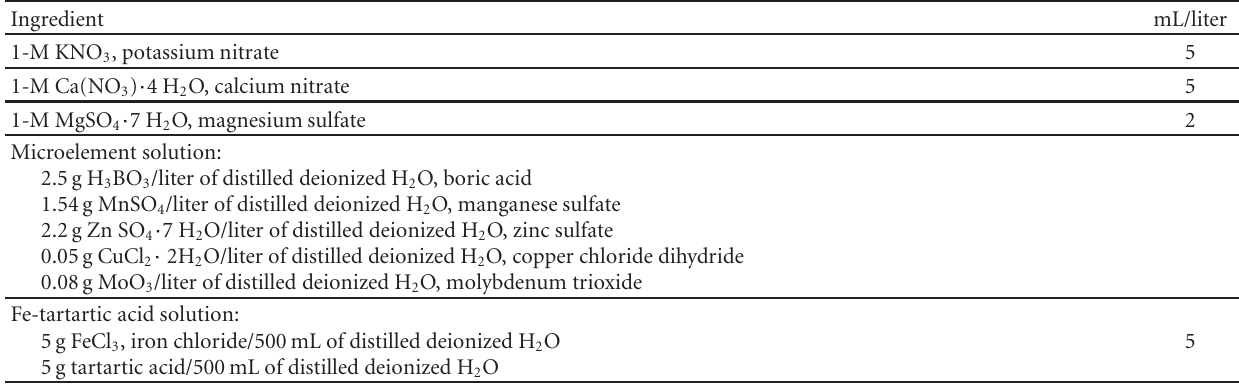
Table 1: Greenhouse nutrient solution.